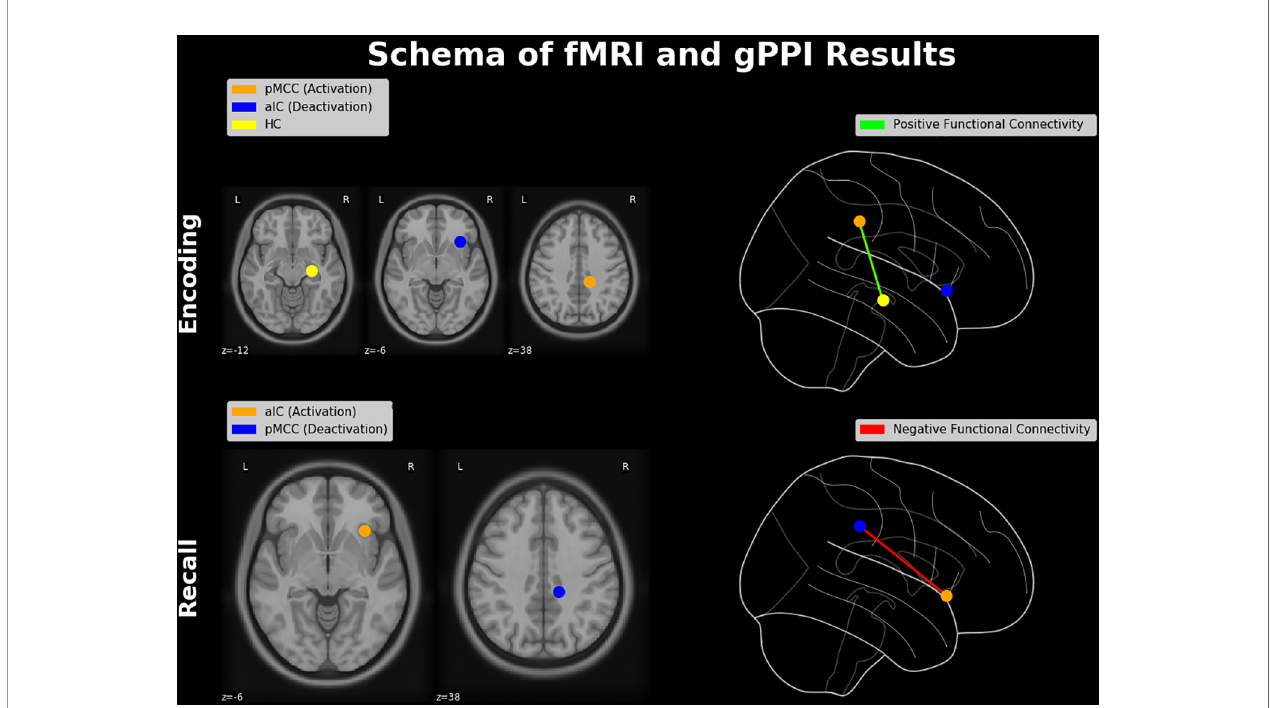
FIGURE 7 | Schematic diagram of neuroimaging fi ndings. Regions showing a pattern of antagonistic activation (i.e., activation and deactivation) during memory encoding and retrieval (constituting an E/R fl ip) and their functional connectivities. During encoding, activation in the pMCC is positively connected with the hippocampal formation, while the aIC is deactivated. During retrieval, the aIC is positively activated and thereby negatively connected with the PMR, which itself exhibits a signi fi cant deactivation. Brain regions were schematically rendered onto a T1 template (left-hand side) and projected in a glass brain (right-hand side). HC, hippocampus; pMCC, posterior middle cingulate